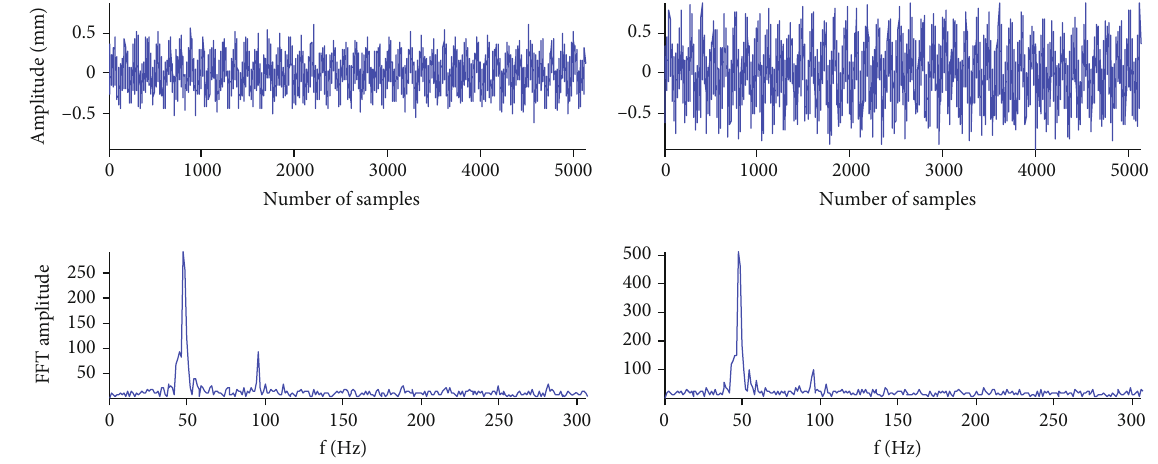
Figure 8: Time frequency domain waveform of rotor coupling fault vibration signals.